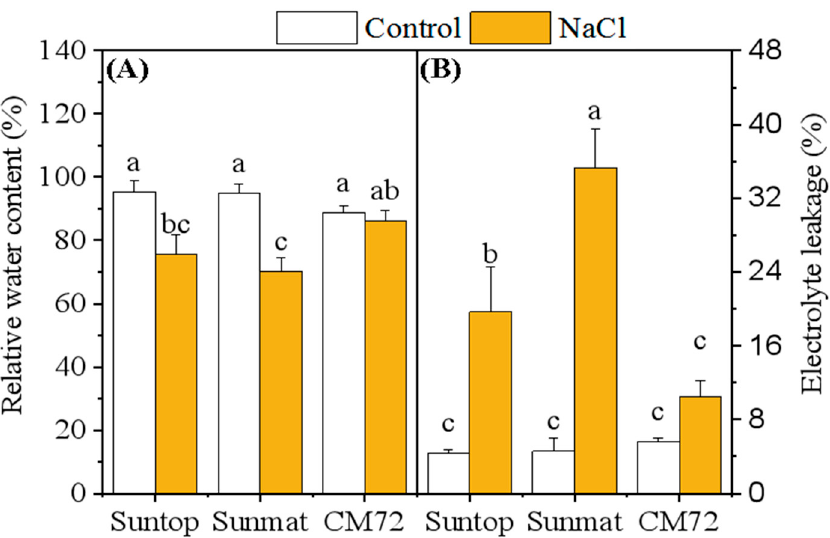
Figure 1. Relative water content ( A ) and electrolyte leakage percentage ( B ) in leaves of two wheat cultivars—Suntop and Sunmate—and one barley cv . CM72 after 7 days of exposure to 100 mM NaCl. Control and NaCl represent 0 and 100 mM NaCl, respectively. Values are means ± SD (n = 4). Different letters indicate a significant difference ( p ≤ 0.05) between NaCl treatment and control within each wheat and barley cultivar.